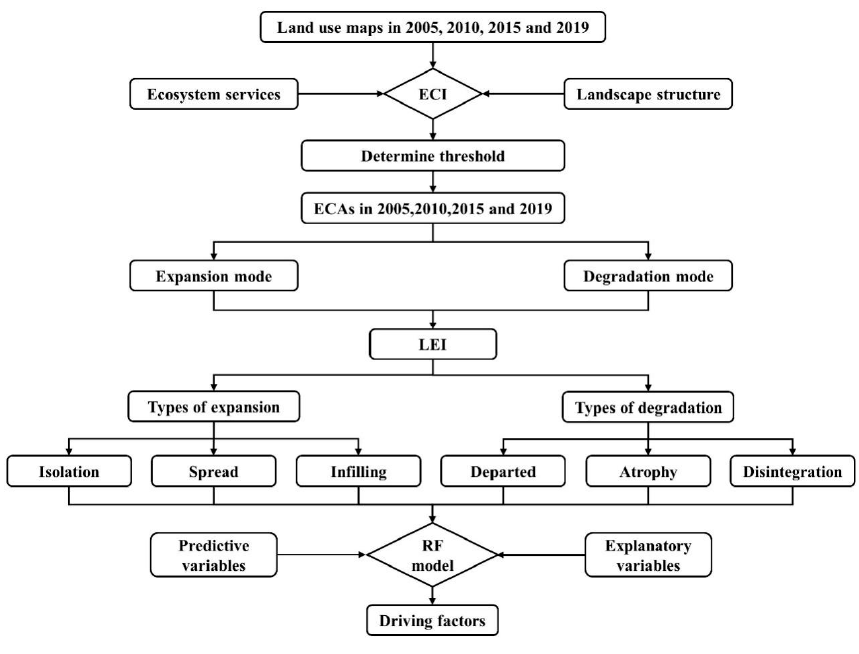
Figure 2. Research